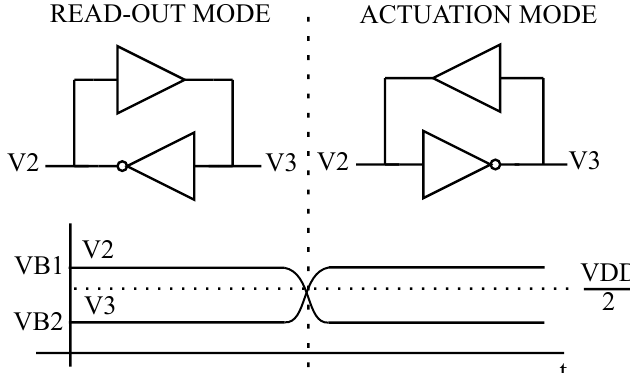
Figure 13. Bias point analysis during a transition between